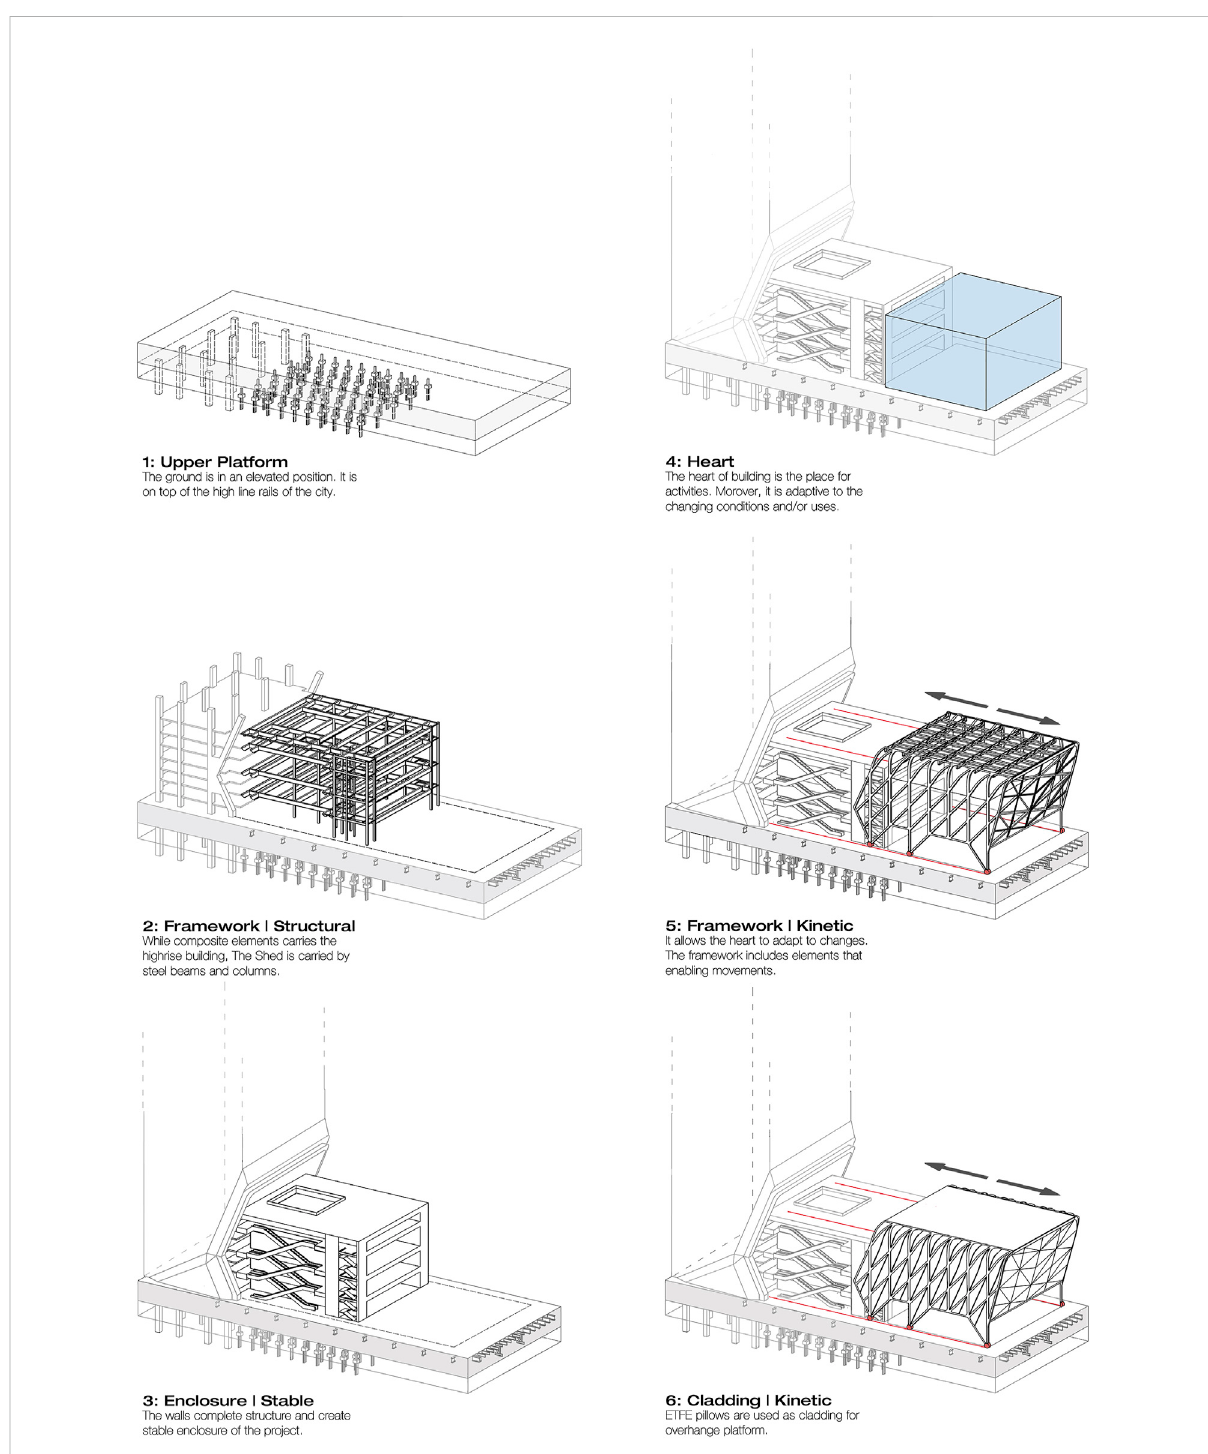
FIGURE 7 Anatomy of The Shed (drawn by the